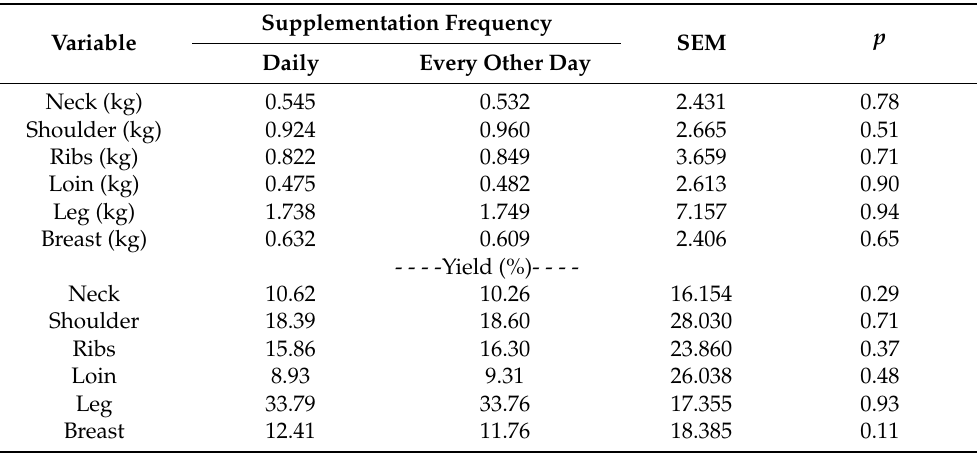
Table 6. Weights and yields of meat cuts of sheep submitted to intermittent supplementation on Masai grass